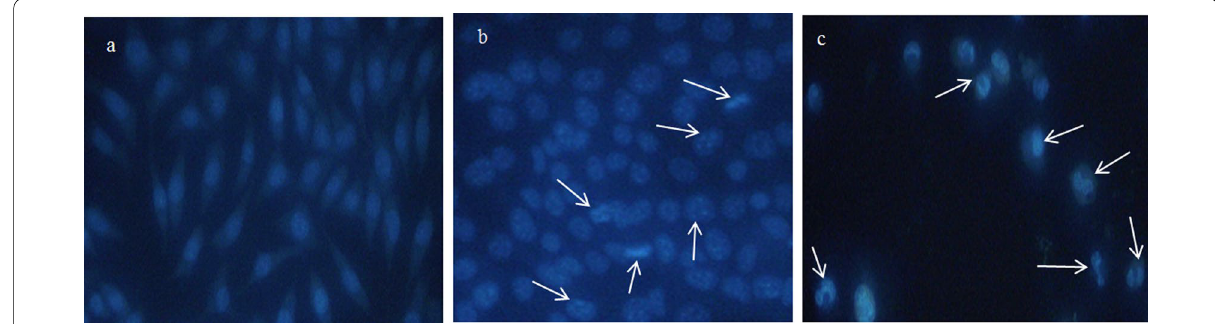
Fig. 10 DAPI nuclear staining of ( a ) control, b cisplatin-treated, and c AgNPs-treated